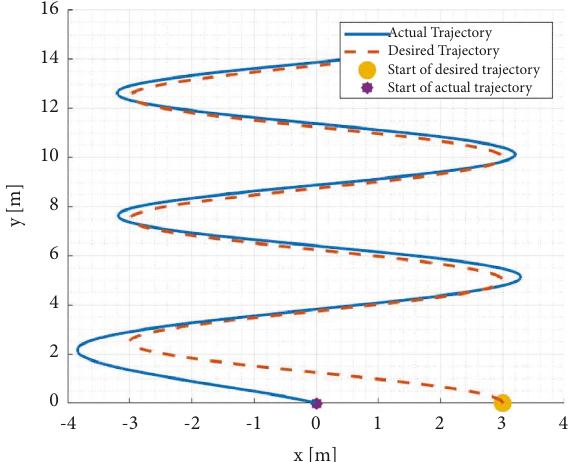
Figure 13: Desired and actual trajectories with PD